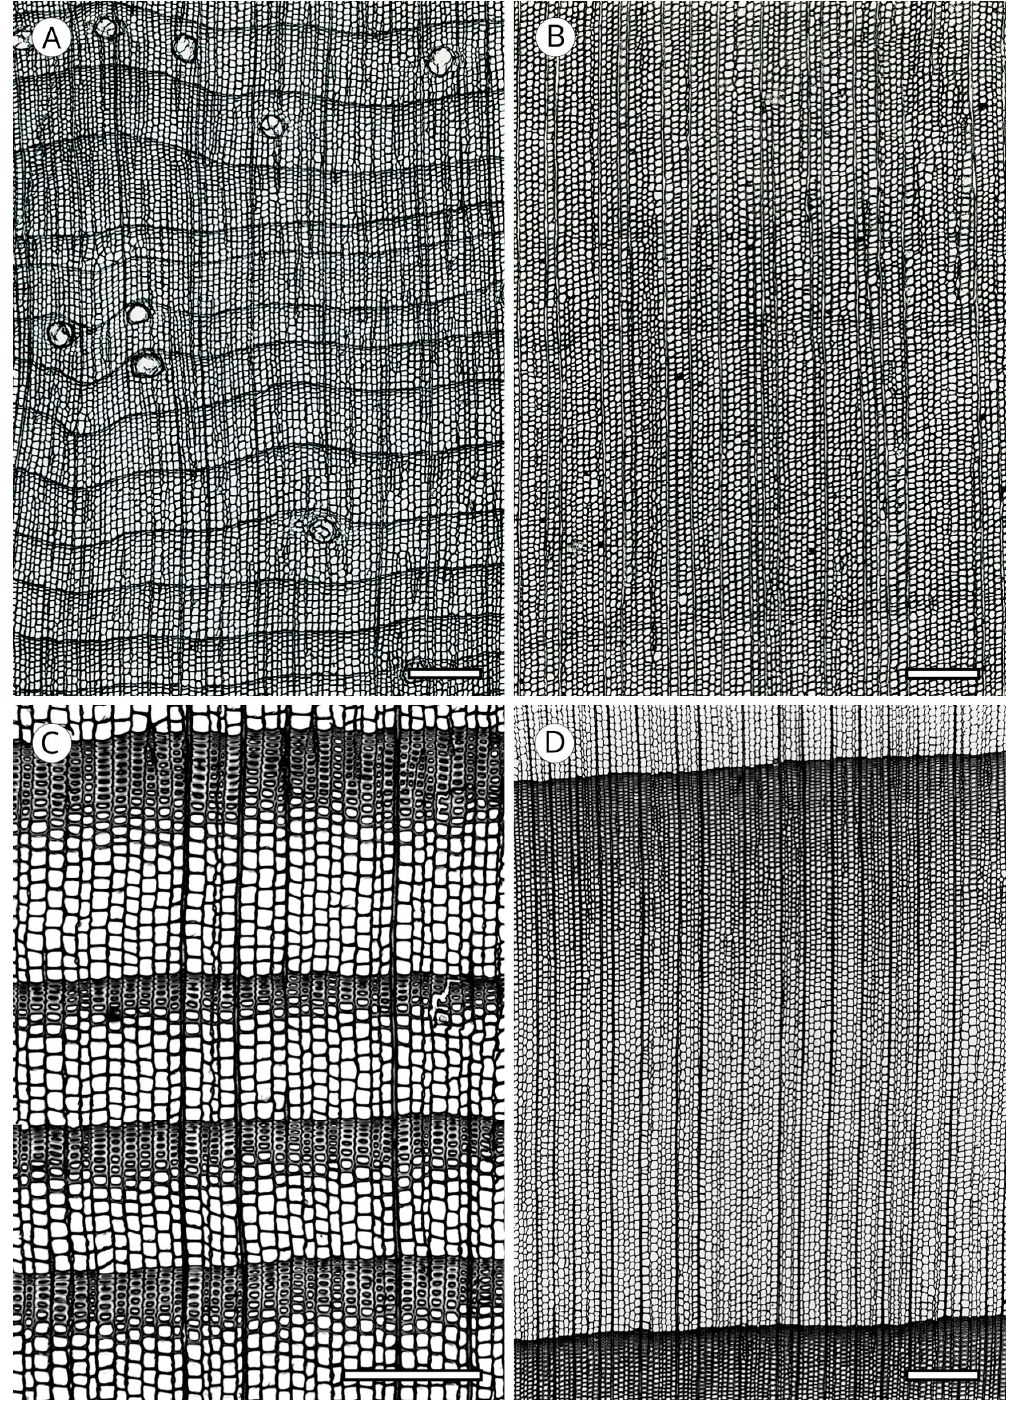
Figure 7. Growth rings. ( A ) Distinct growth ring boundaries in Pinus cembra L.; ( B ) Indistinct growth ring boundaries in Afrocarpus gracilior (Pilg.) C.N.Page; ( C ) Growth rings with abrupt transition in Abies nordmanniana subsp. equi-trojani (Asch. & Sint. ex Boiss.) Coode and Cullen; ( D ) Growth rings with gradual transition in Abies alba Mill. Scale bars. ( A – D ) = 500 μ m.